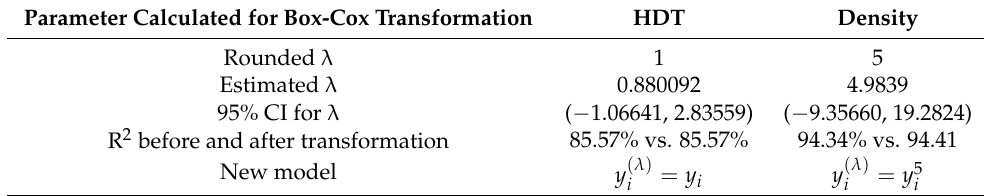
Table 3. Parameters calculated for Box–Cox transformation of HDT and density.